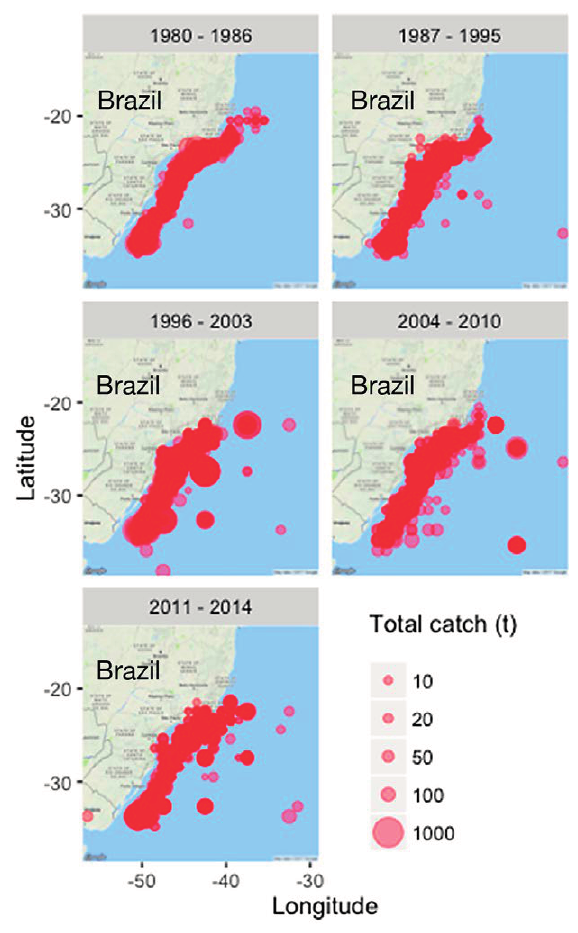
Fig. 4. – Space-time distribution of the total catch by time period off southeast BR. A stronger or lighter red colouration indicates the density of the point cloud.